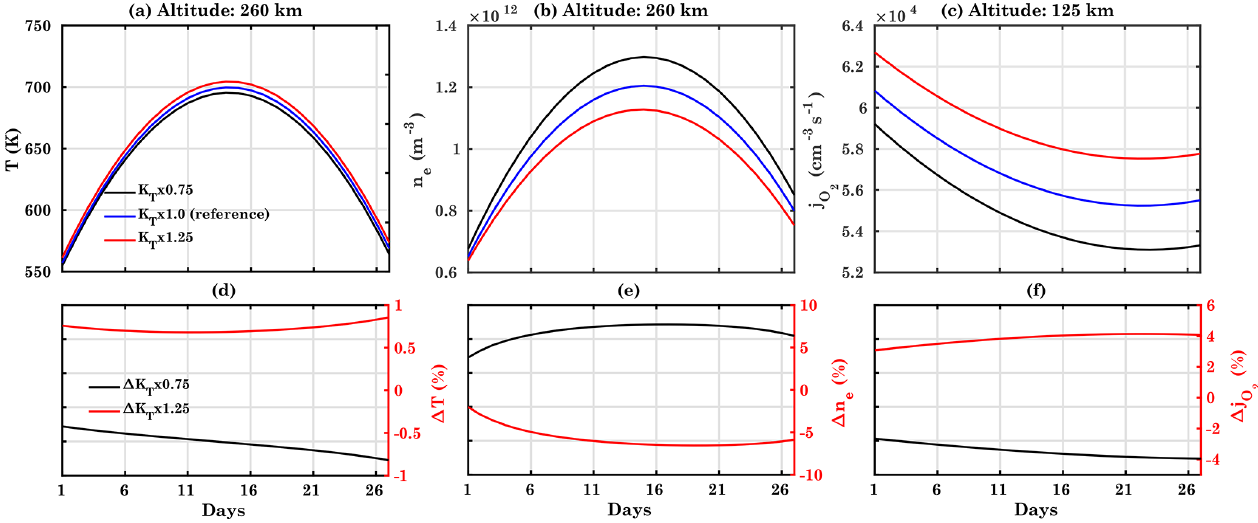
Figure 9. Same as Fig. 8 for (a) T , (b) n e for the pressure level 12 ( ∼ 260km), and (c) j O fusion, but also by temperature, pressure, and neutral species, etc. All these parameters are affected by solar EUV